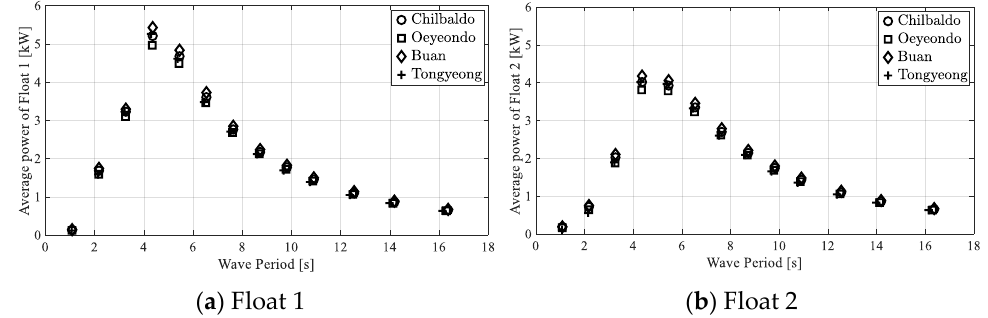
Figure 17. Comparison of the average power production of each location according to the wave periods.